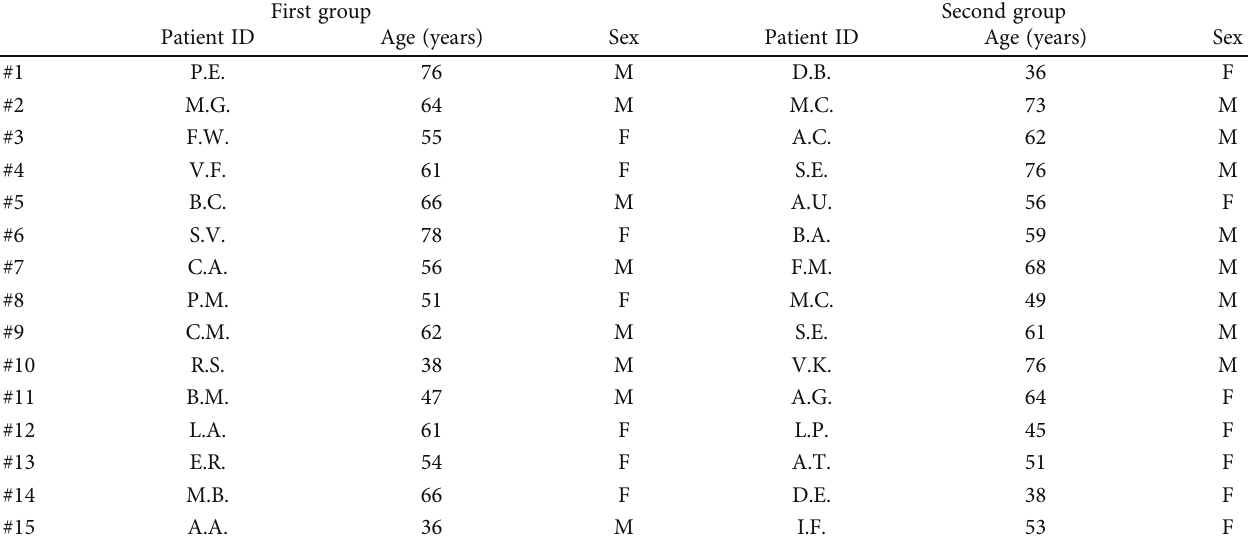
Table 3: Characteristic of